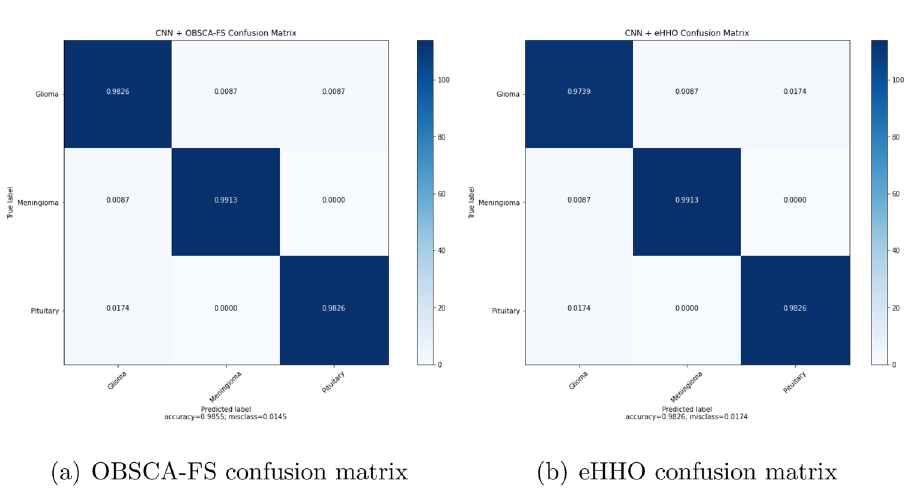
Figure 8. Confusion matrix for OBSCA-FS and eHHO, the two approaches that scored the best results on the MRI